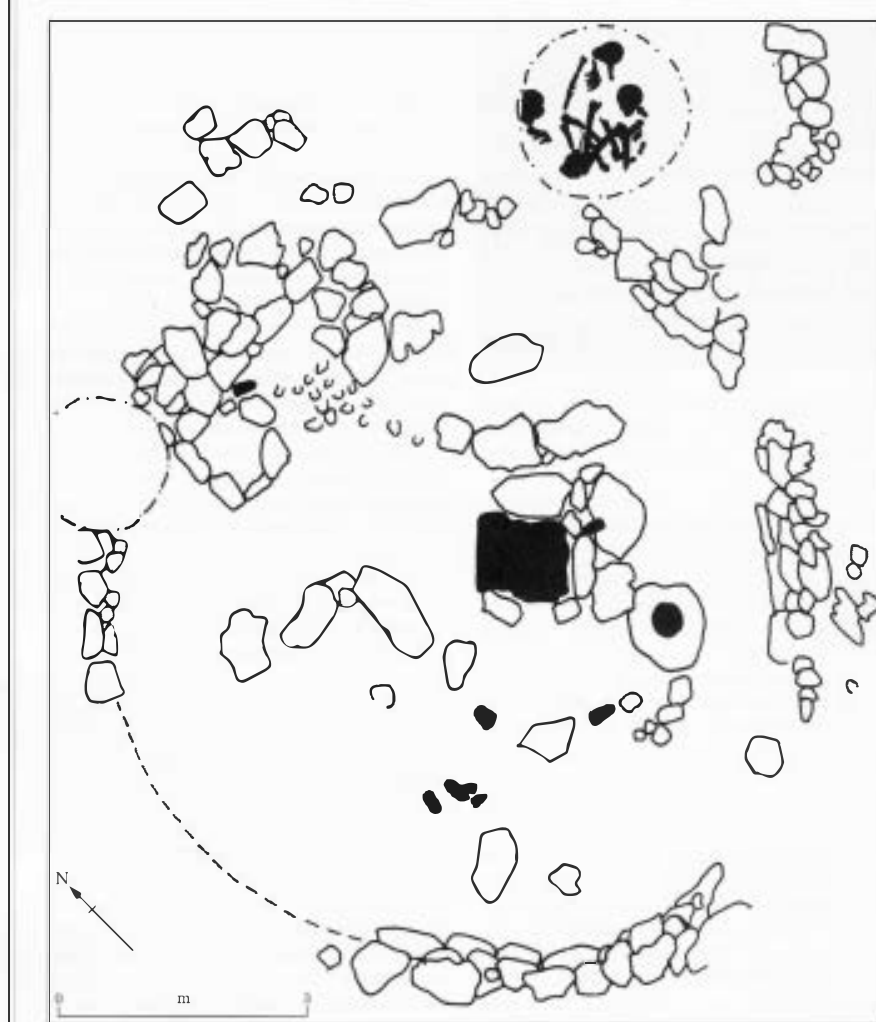
A Natufian house (no. 26) at 'Ain Mallaha, Israel (redrawn from Perrot 1966, n. 1 7). The black features consist of a rectangular hearth in the centre; a large boulder mortar south of the hearth, with its circular use-surface shown in black; ground stone artefacts, mainly pestles, west of the hearth and boulder; and a burial just outside the structure on the eastern